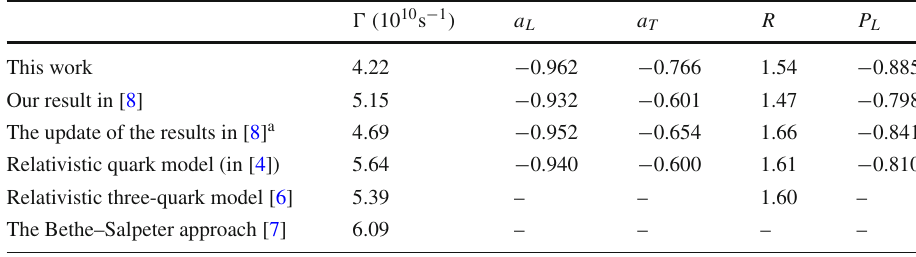
polarization asymmetries of (cid:2) → (cid:2) ¯ ν b c l l